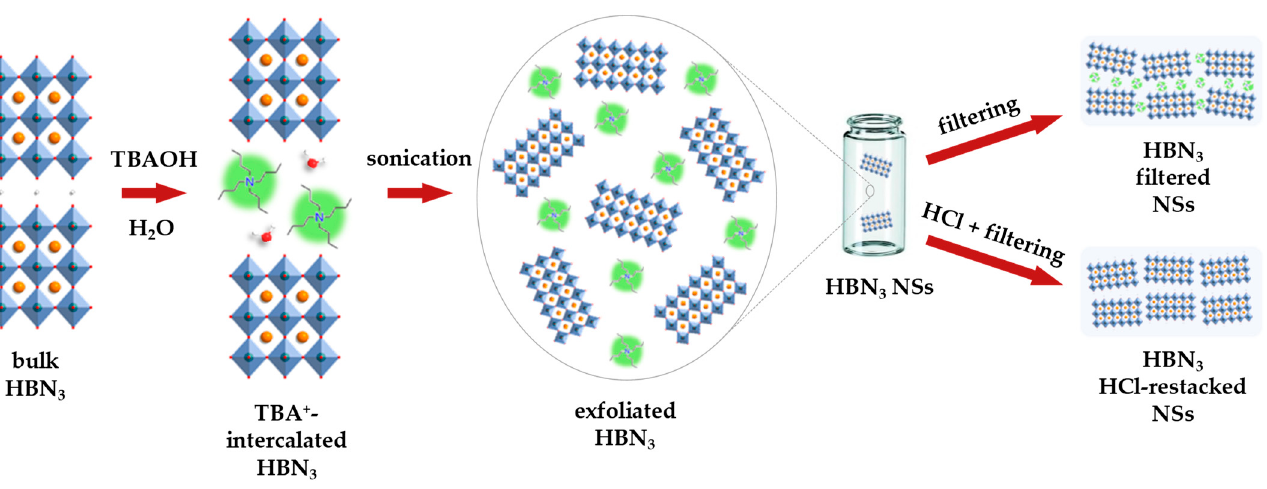
Figure 9. Exfoliation of the protonated niobates into nanosheets and two approaches to their reas-